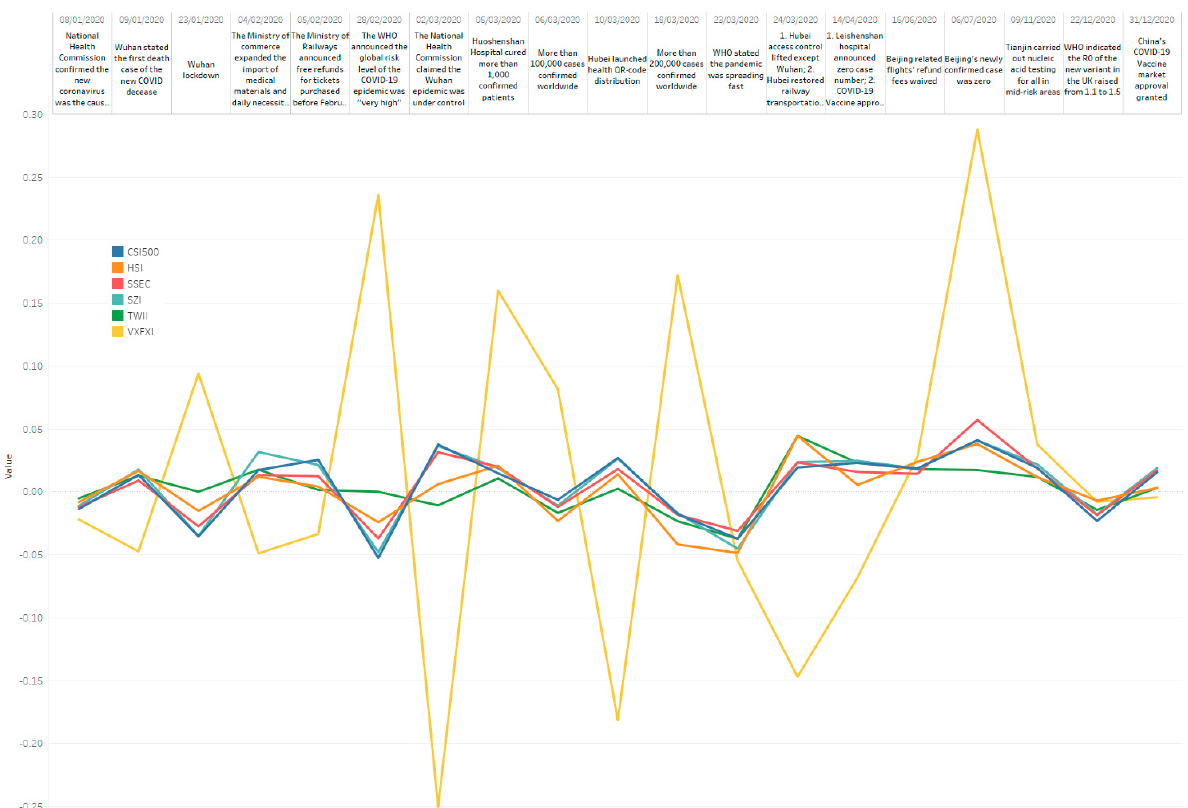
Figure 9. Major social events and stock market trends in 2020 in China (line).